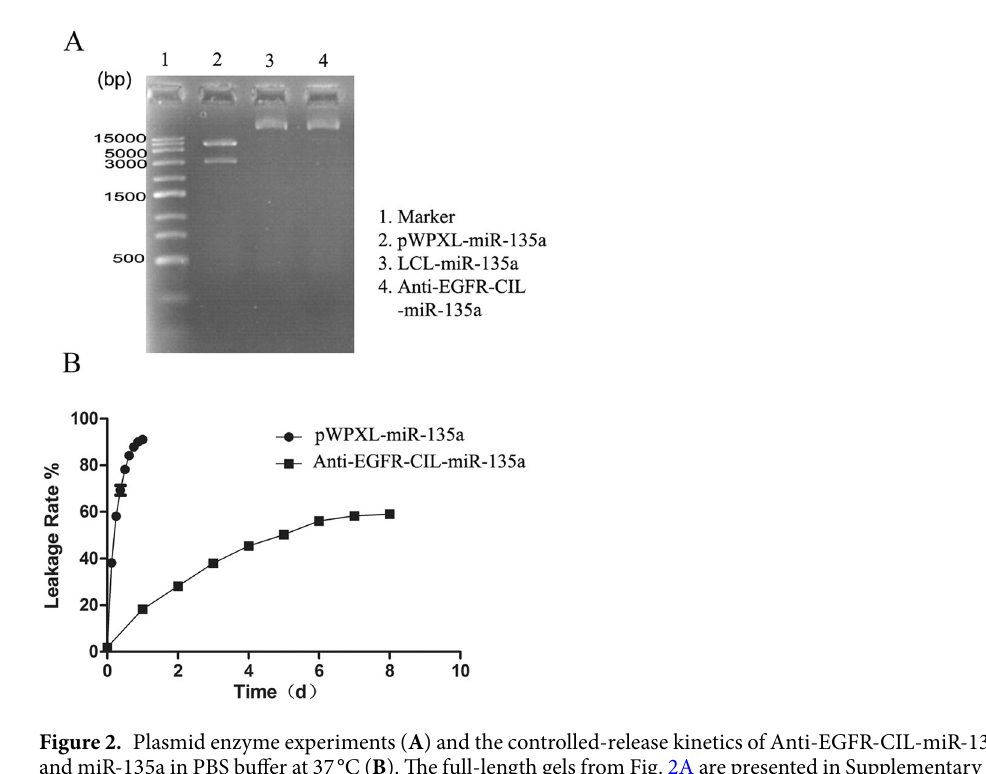
(Fig. 1B,C, Table 2). Based on TEM imaging, Anti-EGFR-CIL-miR-135a liposomes were spherical with a smooth surface (Fig. 1A). The encapsulation and drug loading efficiencies were 73.91% and 1.43%, respectively. Protective and controlled-release liposome efficacy.